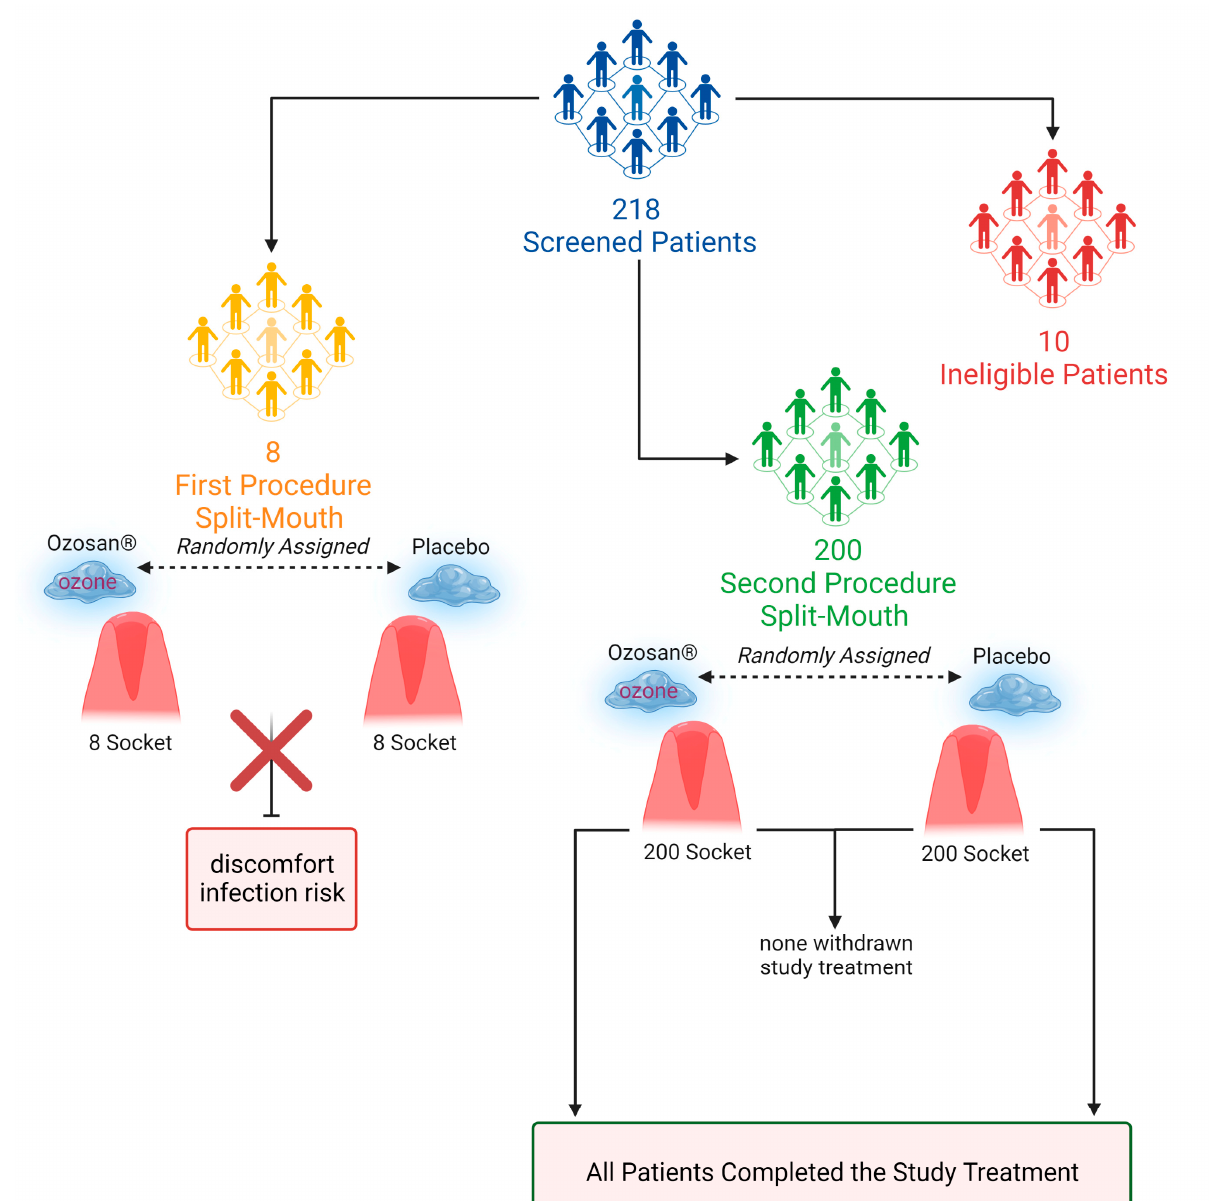
Figure 1. Design of experimental set-up according to CONSORT guidelines.